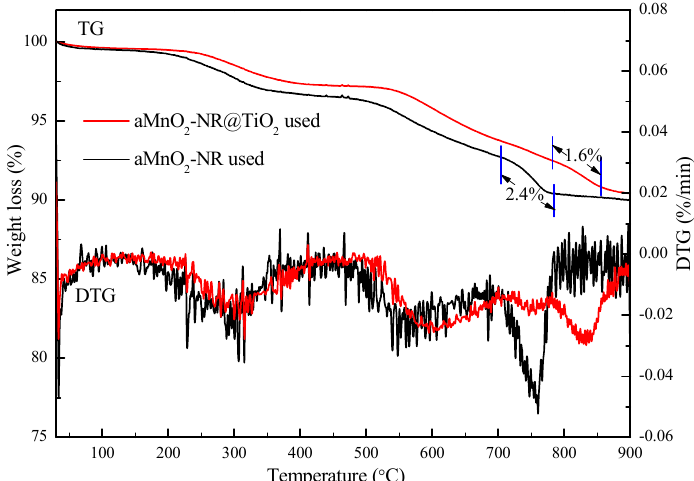
Figure 10. Thermo-gravimetric (TG) and differential thermos-gravimetry (DTG) of spectras of α MnO α MnO 2 -NR and 2 -NR@TiO 2 after SO 2 αMnO 2 -NR and αMnO 2 -NR@TiO 2 after SO 2 treatment.